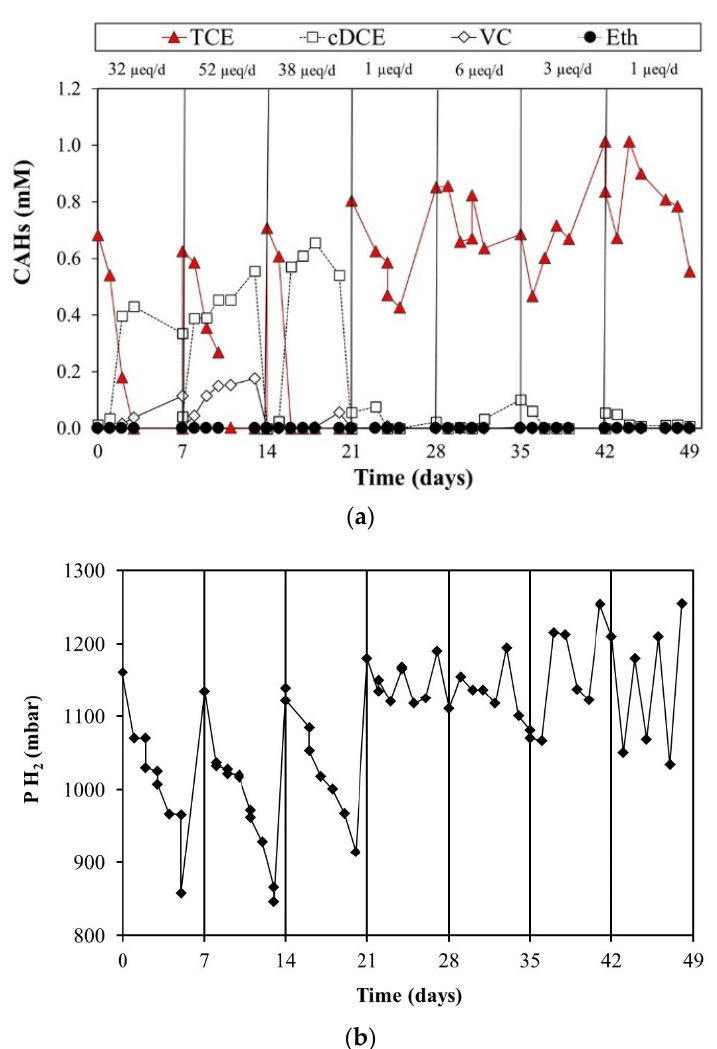
Figure 4. H 2 -fed reactor monitoring ( a ) and H 2 partial pressure behavior over time ( b ).